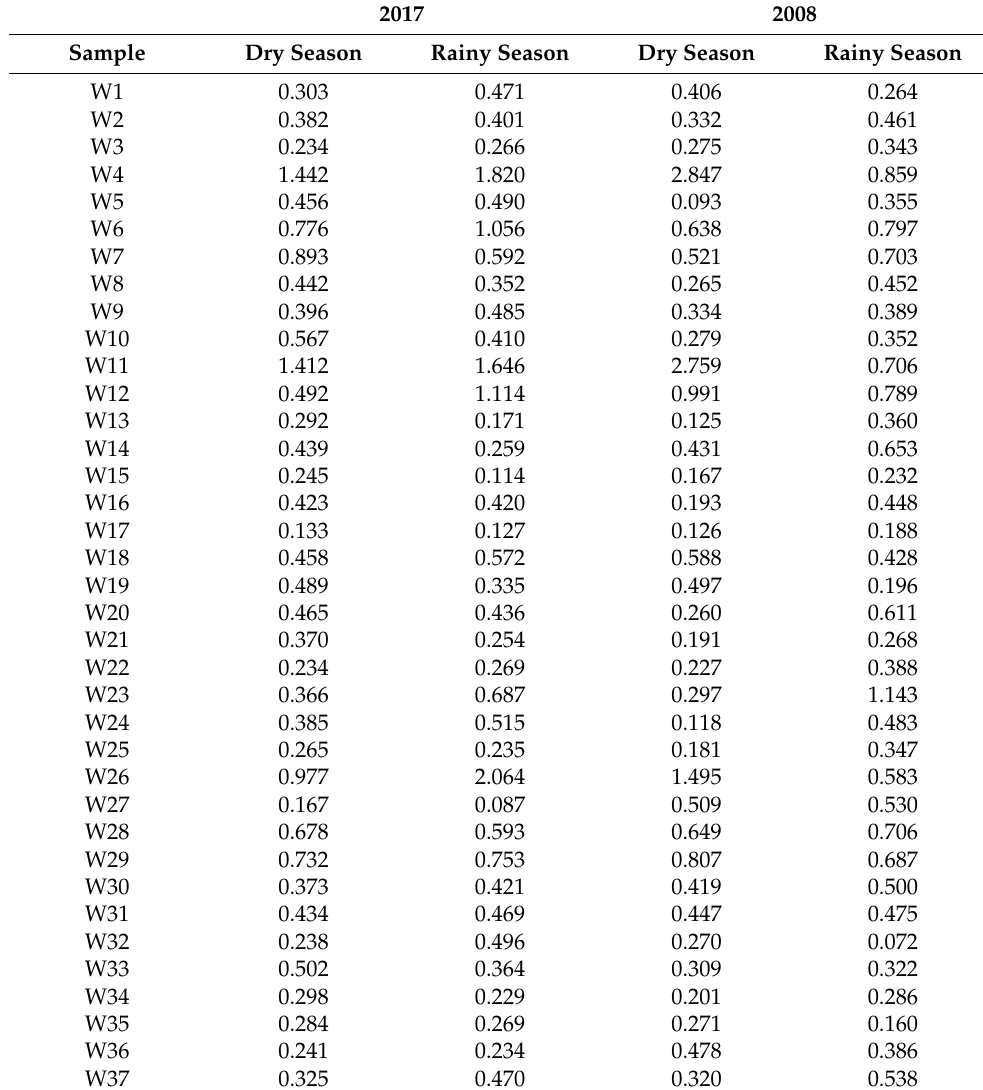
Table 3. Non-carcinogenic risk assessment for